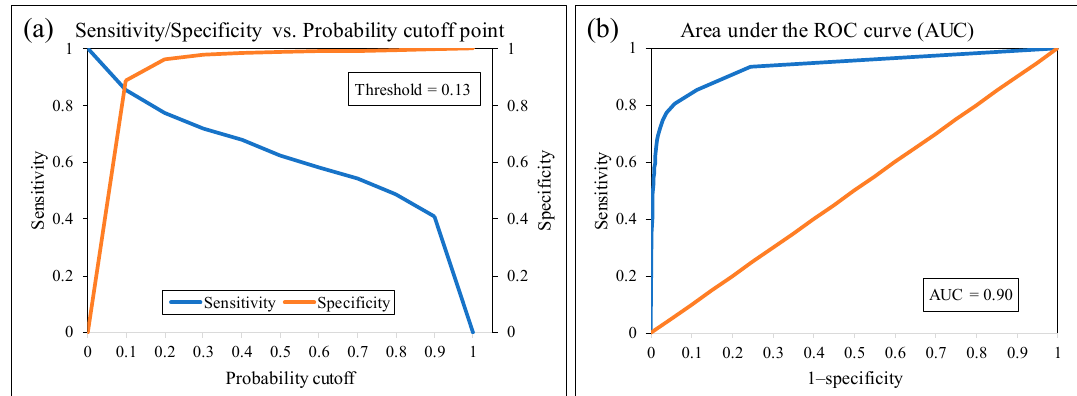
Figure 6. Effect of cutoff value on sensitivity and specificity of test results when cutoff value is: ( a ) 0.1; ( b ) 0.3; ( c ) 0.5; and ( d ) 0.8.